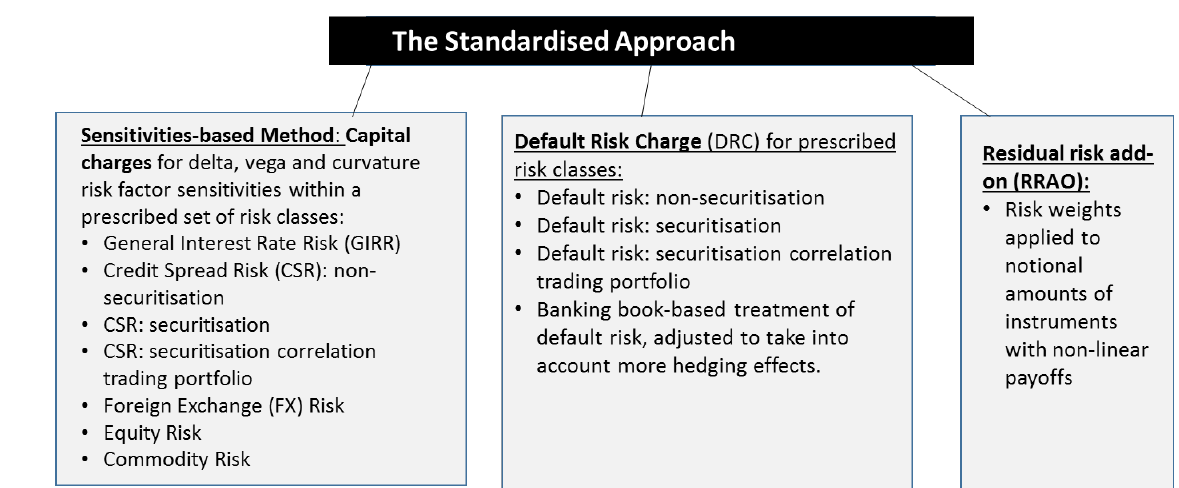
Table 3. The standardized approach to market risk.